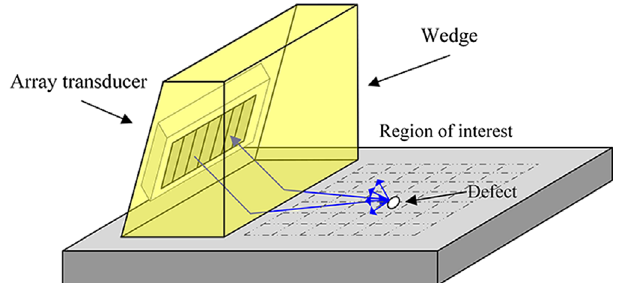
Figure 1. Schematic view of surface defects imaging based on FMC/TFM using array transducers with a wedge.